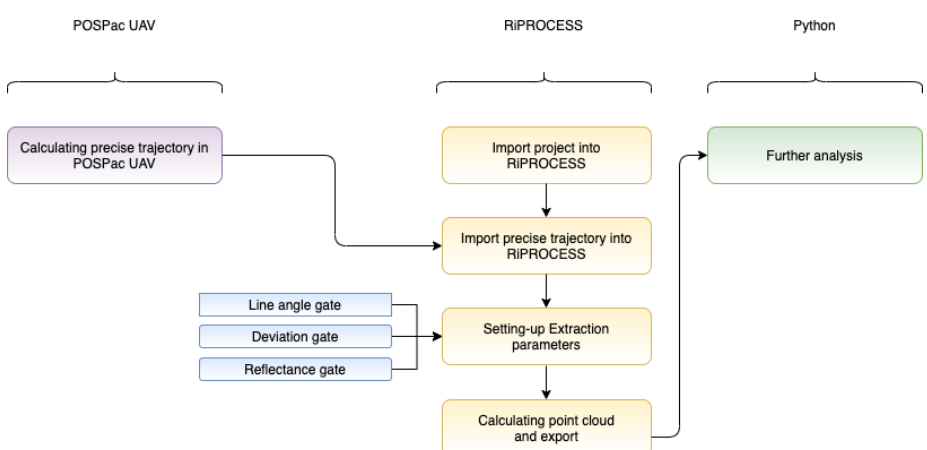
Figure 1. Workflow of LiDAR data pre-processing.